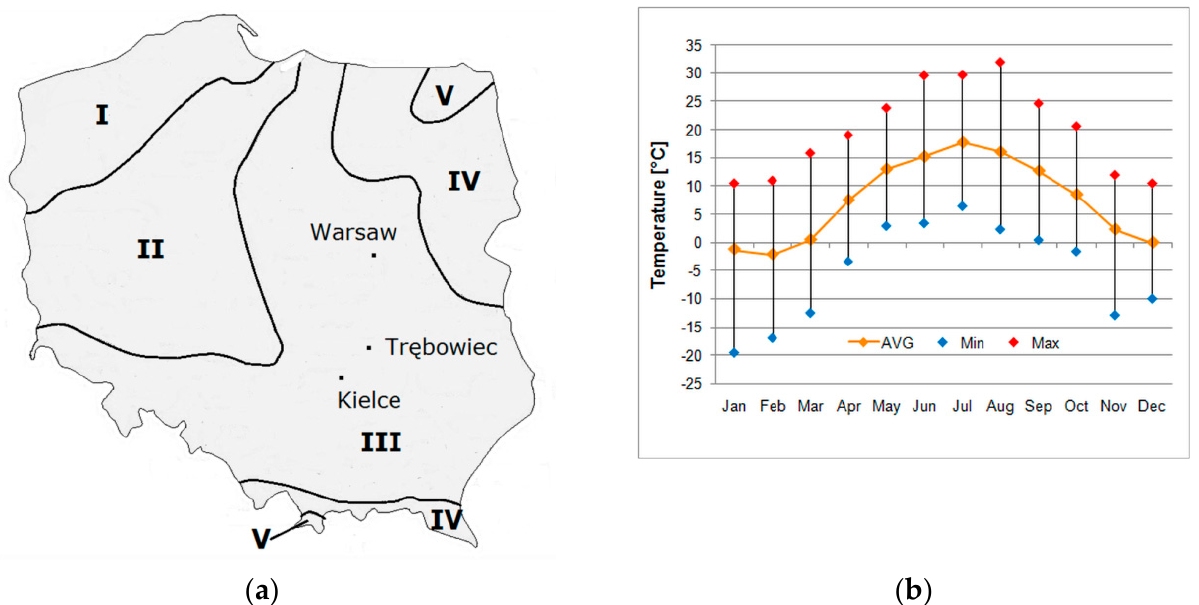
Figure 1. Considered locality. ( a ) Polish thermal zones according to PN-EN 12831and location of Tr ę bowiec. ( b ) Monthly average, minimum, and maximum air temperature for Kielce meteorological station [71].